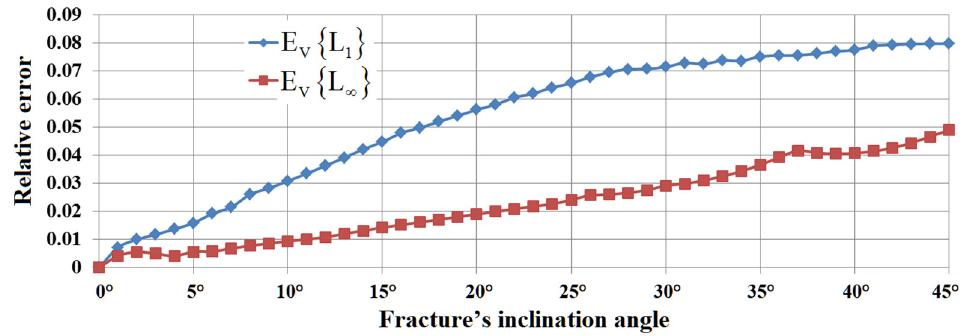
Figure 6. Dependence of the relative errors on the angle α . In (11) and (12), v i , j , v i , j denote the velocity field components obtained using the X Y proposed method in the original coordinate system; V i , j , V i , j represent the velocity field X Y rotated on angle α . In (11) and (12) and further in the text, N R denotes the number of